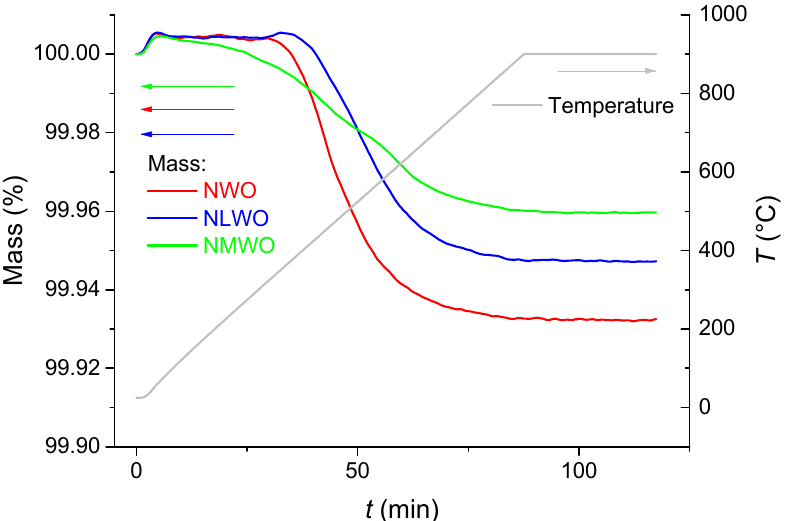
Figure 5. TGA curves of samples synthesized by mechanical activation and sintered using electron beams: NWO (red curve), NLWO (blue curve) and NWMO (green curve).